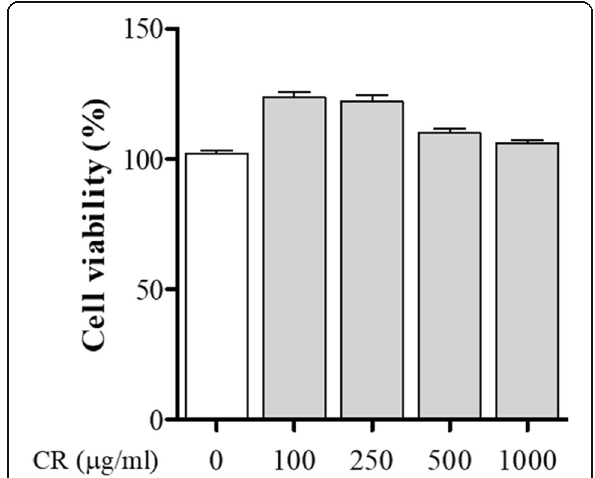
Fig. 2 Effect of CR on RAW 264.7 cell viability was determined by MTS assay . Determination of cytotoxicity of CR on RAW 264.7 cells. Columns and error bars represent the mean ± S. E of three independent